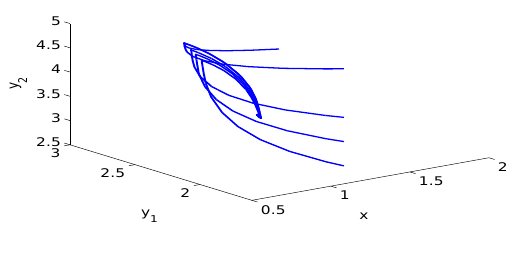
Figure 6: µ = 20 , τ = 10 , E * = (0.7953, 1.9162, 3.8323) of system (1.4) with different initial values is locally asymptotically stable.